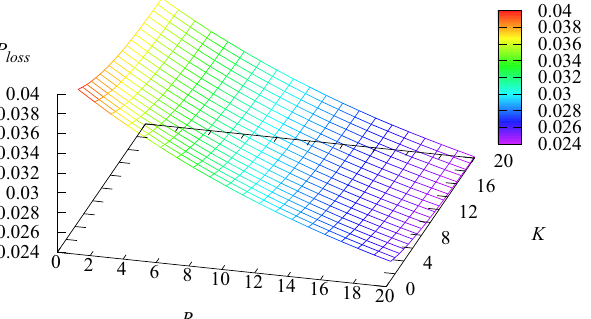
Figure 18. Dependence of the loss probability P loss and R .